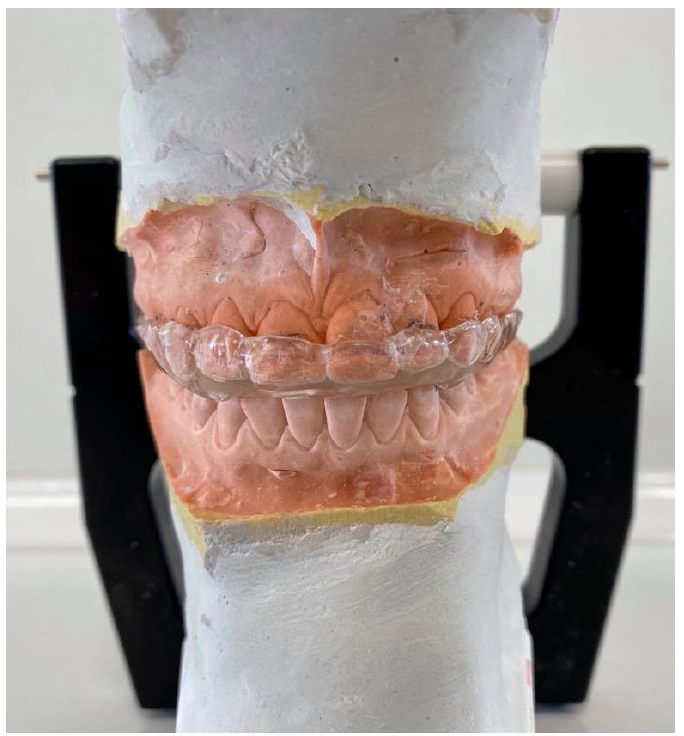
Figure 3. An occlusal appliance.